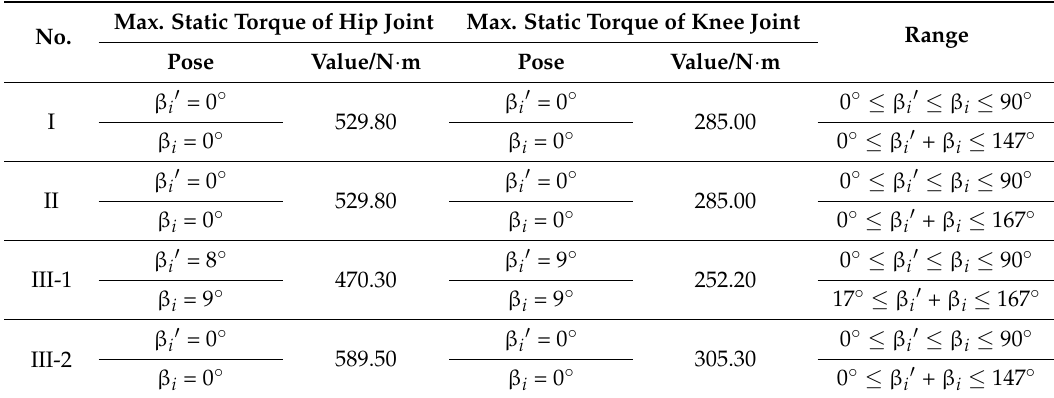
Table 2. Maximum static torques of hip joint and knee